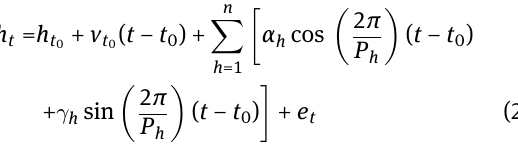
Figure 3: Year-by-year temperature changes, using first differences calculated from: ∆T = T t − ρT t −1 , ρ = 0.82 .